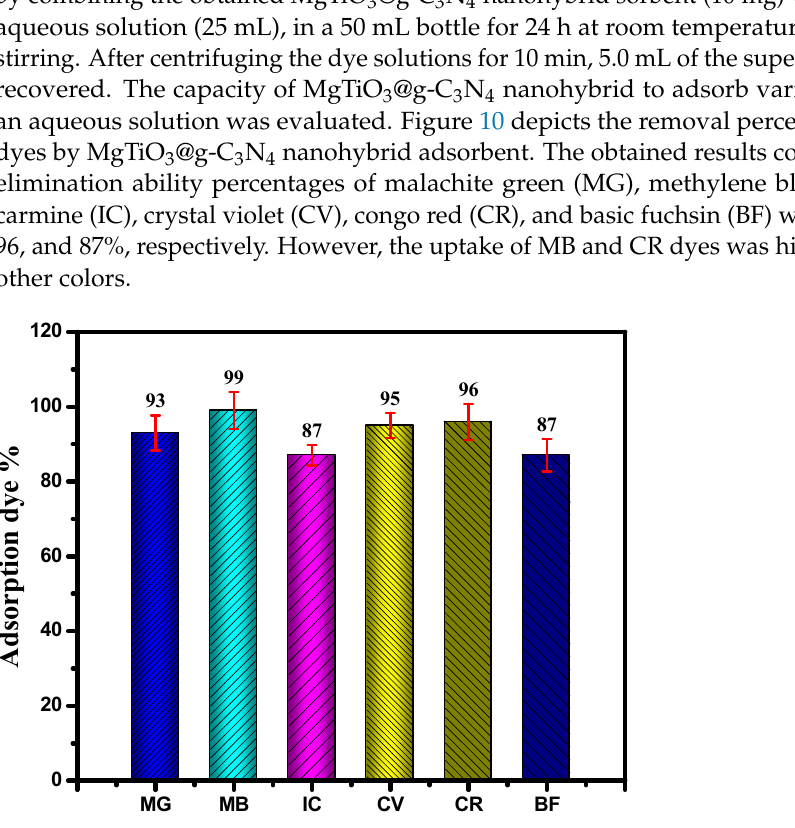
Figure 9. Reuse investigations for the regenerated MgTiO 3 @g-C 3 N 4 in removing RhB.